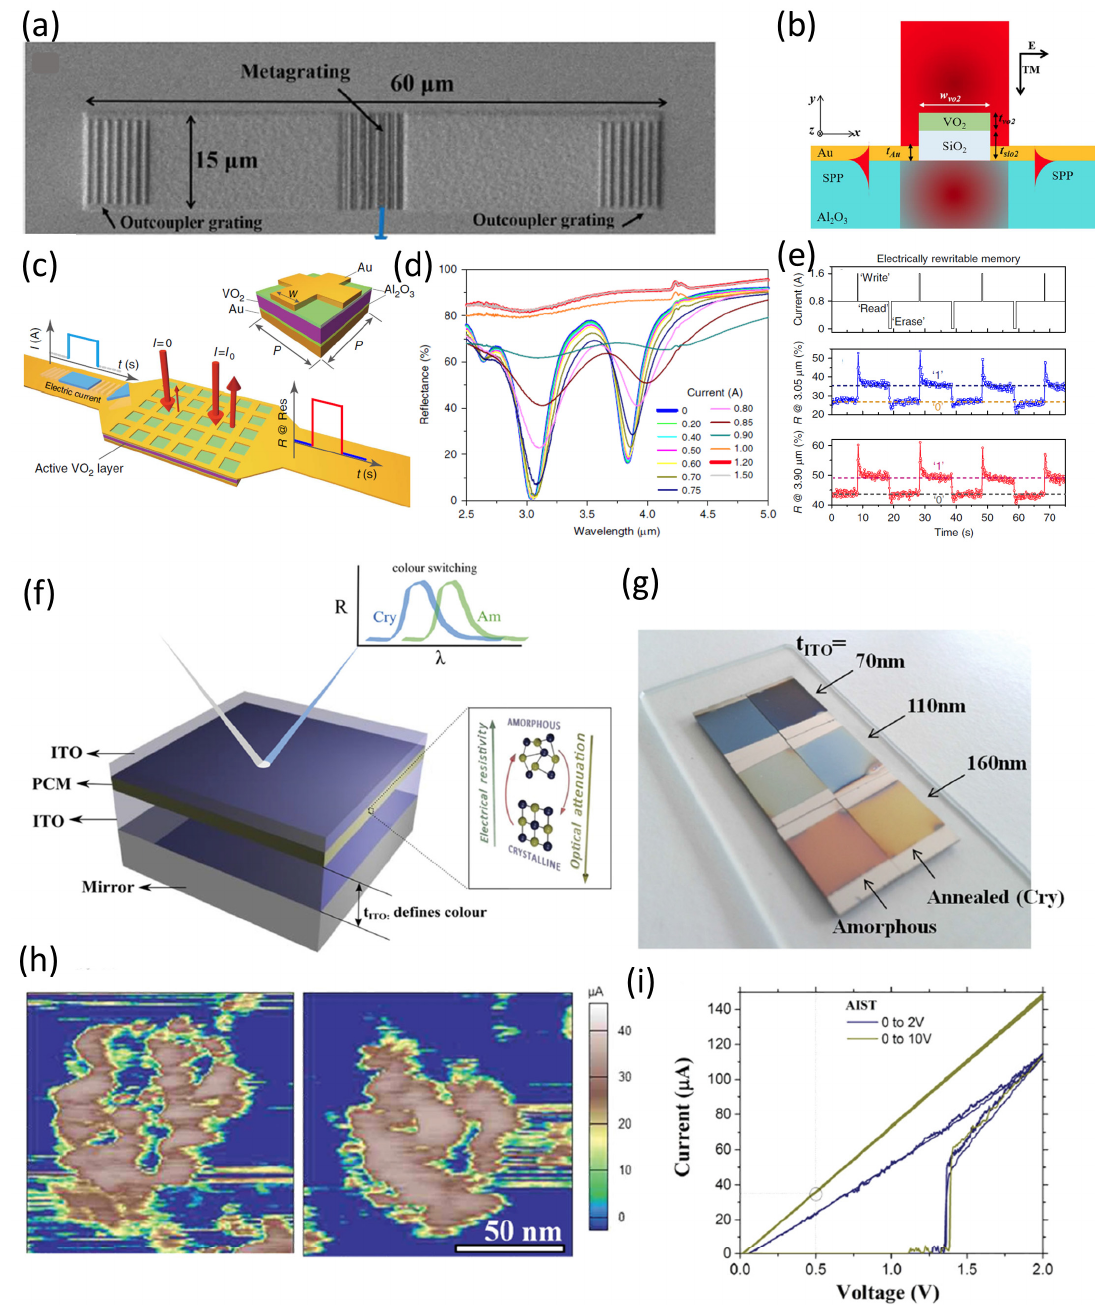
Figure 10. Other phase change metasurfaces. ( a – e ) VO 2 -based metadevice: ( a ) SEM image of the VO 2 -based metagrating device with two outcoupling gratings at both sides; ( b ) An illustration of the metadevice with a symmetric nanoantenna and the initiated SPPs at both sides; ( c ) Schematic configuration of the VO 2 -based metadevice with a packed PCM between two Au metals and spacer layer of Al 2 O 3 ; ( d ) Reflection spectra with different electrical currents to tune the spectral resonances. ( e ) Rewritable memory effect of the metadevice; ( f – i ) AIST-based metadevice: ( f ) A representation of an AIST-based color filter; ( g ) The generated colors using an AIST-integrated metafilter; ( h ) Resolution of created nanopixels on AIST using CAFM; ( i ) I – V curves of the AIST film obtained by CAFM. ( a , b ) are adapted from [79], with permission from © 2017 Nature Publishing Group; ( c – e ) are adapted from [80], with permission from © 2016 Nature Publishing Group; and ( f – i ) are adapted from [71], with permission from © 2016 WILEY-VCH Verlag GmbH & Co. KGaA,